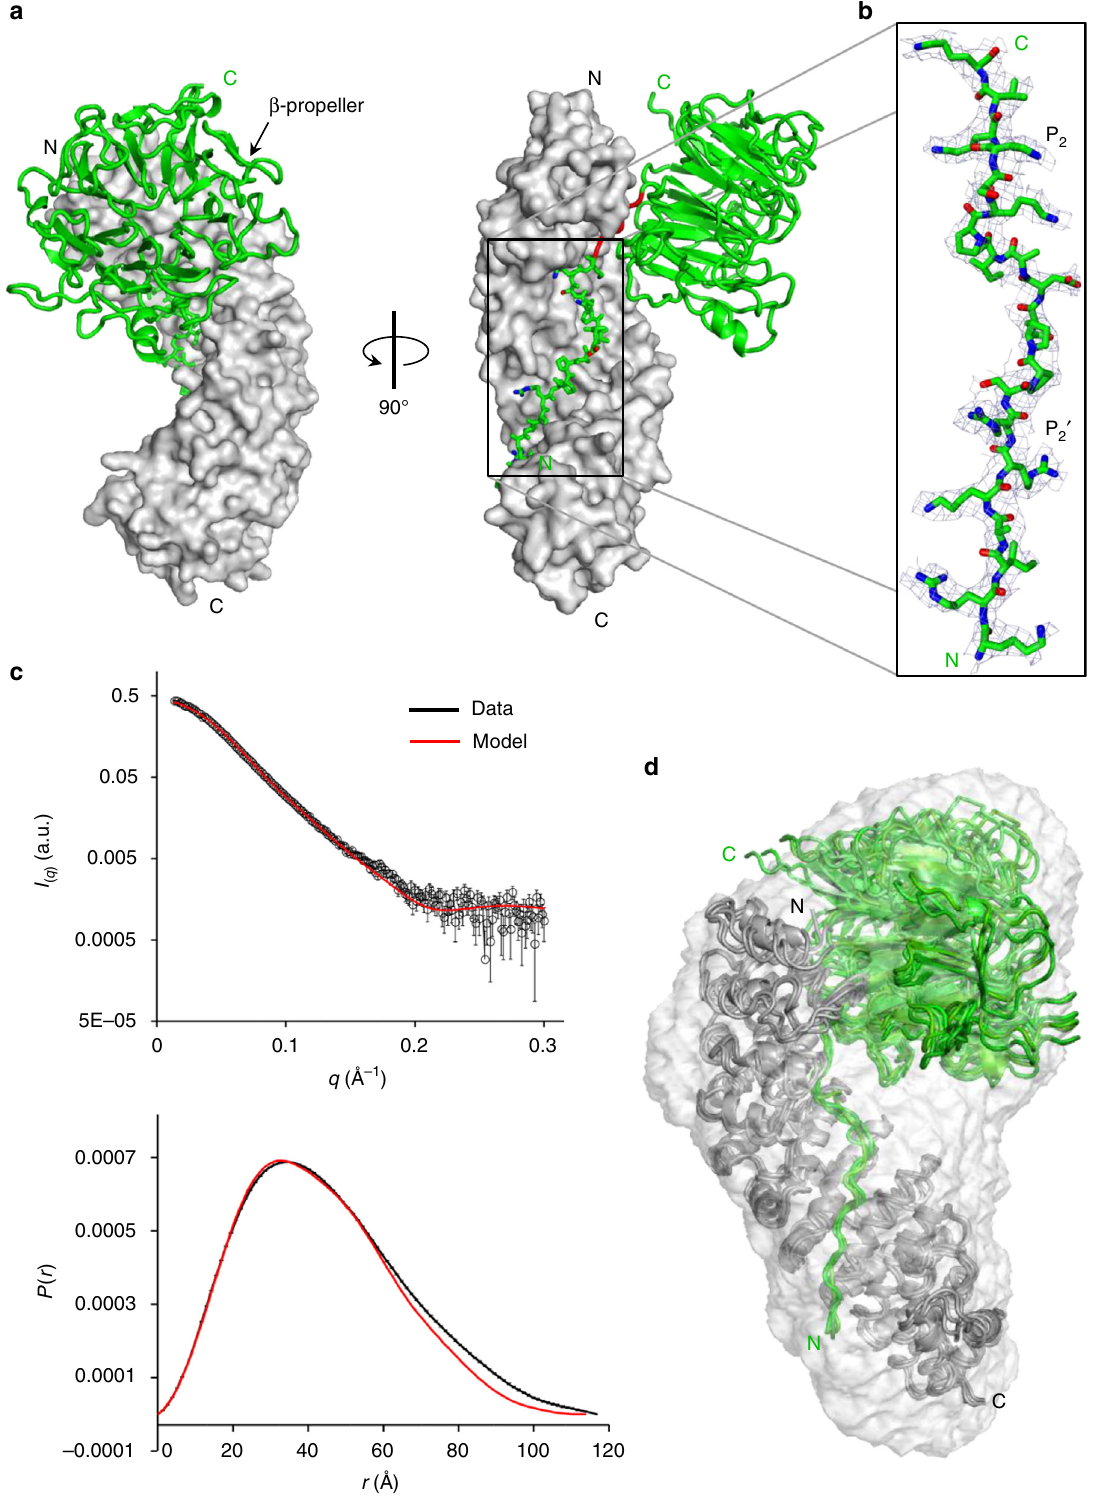
Fig. 2 Structure of human importin α 3 bound to RCC1. a A representative structure of the human importin α 3:RCC1 complex with RCC1 (ribbon diagram) and importin α 3 (solvent surface) colored in green and gray, respectively. RCC1 hinge residues (23 – 27) are colored in red. b Eight-fold non-crystallographic symmetry averaged 2 F o − F c electron density map of the RCC1 NLS displayed at 1 σ above background. The density (in blue ) is overlaid to residues 4 – 24 of the fi nal re fi ned model (in green ). c SAXS analysis of the importin α 3:RCC1 complex. Experimental scattering data (shown in black ) obtained by merging scattering data at 3.5, 5.0, and 7.5 mg ml − 1 ( top panel ) and corresponding distance distribution function P ( r ) ( bottom panel ). Scattering pro fi le and P ( r ) function calculated from the average of the eight importin α 3:RCC1 complexes observed crystallographically are shown in red. d . Ab initio SAXS reconstruction of the importin α 3:RCC1 complex calculated from merged scattering intensities at 3.5, 5.0, and 7.5 mg ml − 1 . Overlaid to the SAXS envelope is a composite of all complexes in the triclinic unit